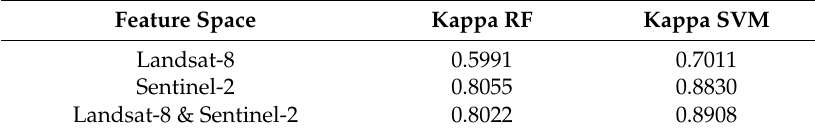
Table 7. Maximum K c values for SVM crop type classifications based on the Sentinel-2 MSI, pan-sharpened Landsat-8 OLI and combined feature